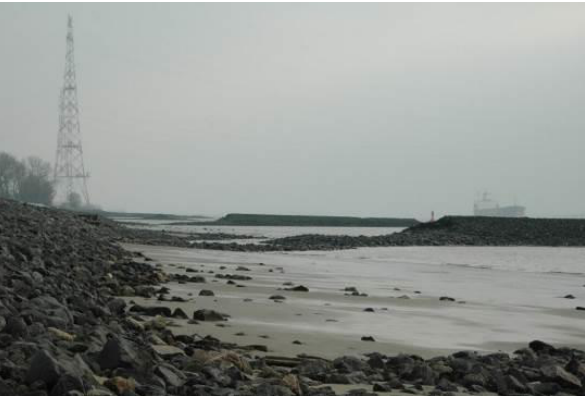
Figure 1. Breakthrough between groyne and revetment connection at Juelssand due to vessel-induced long-periodic wave loads